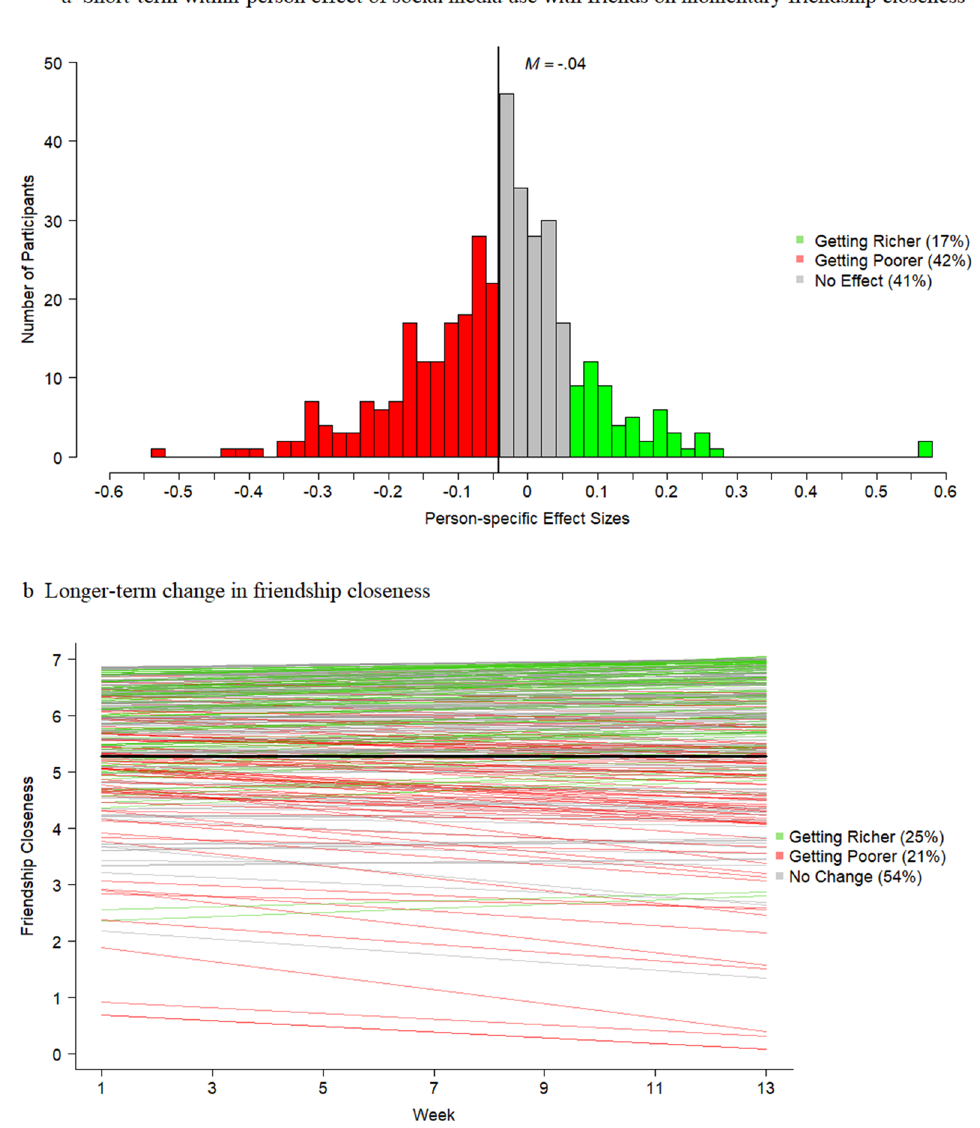
Figure 2. Short-term effects of social media use with friends on friendship closeness (Fig. 2a) and longer-term growth in friendship closeness (Fig.